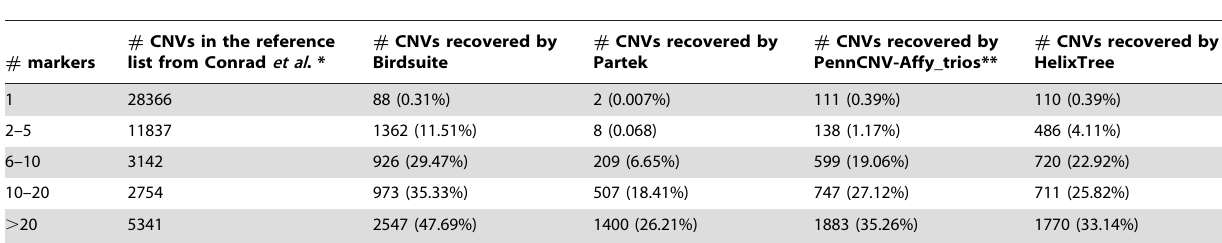
Table 2. The recovery rates of each of the CNV-calling programs depending on CNV length based on data by Conrad et al . in 90 CEU